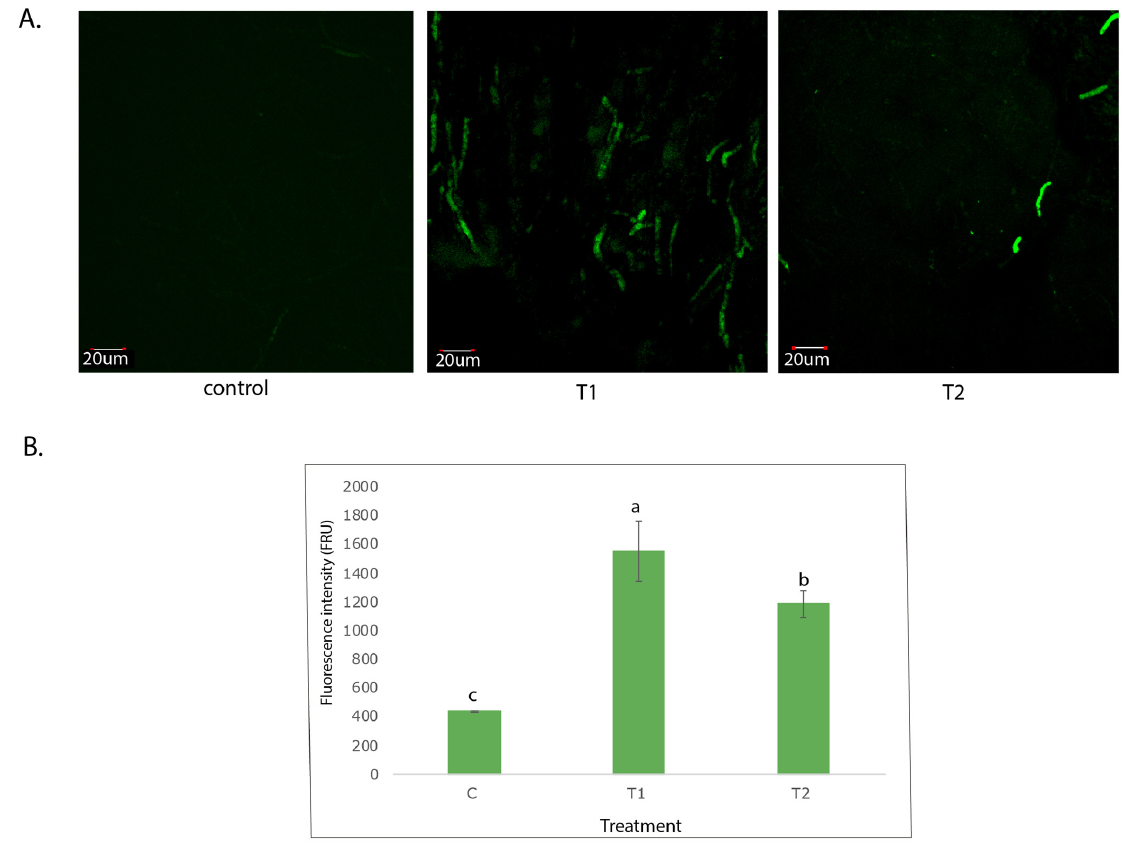
Figure 2. ( A ) Detection of reactive oxygen species (ROS) within Gaeumannomyces graminis hyphae staining with the oxidatively active fluorescent dye 2,7-dichlorodihydrofluorescein diacetate (H 2 DCFDA, Molecular Probes). ( B ) Fluorescence intensity expressed as FRU (Fluorescent Relative Unit). Different letters denote a significant difference ( p < 0.05; Tukey test) between treatments. (c) control, T1: Stress condition under UV-A stress, T2: Stress condition due to temperature change (30, 15, and 20 ◦